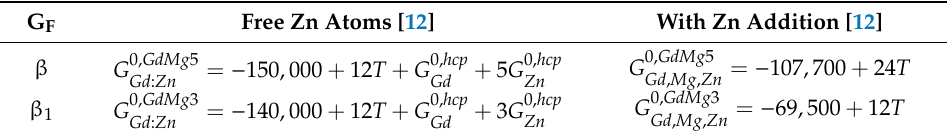
Table 1. The Gibbs energy of phase formation for β phase and β 1